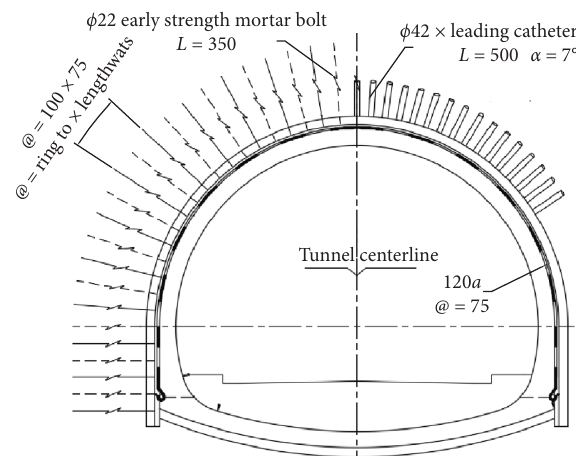
Figure 3: Design drawing of the tunnel support